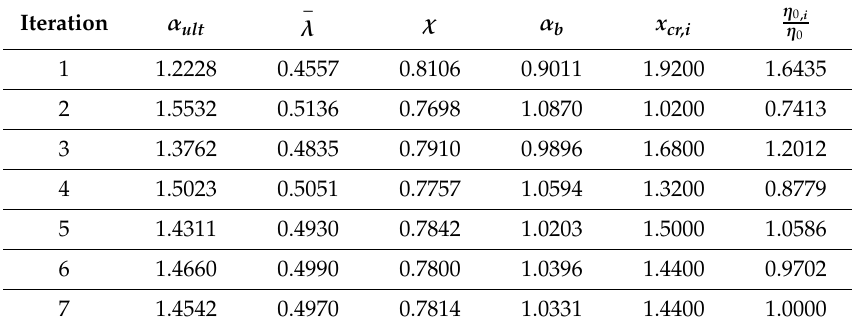
Table 1. Example 1: key values for each